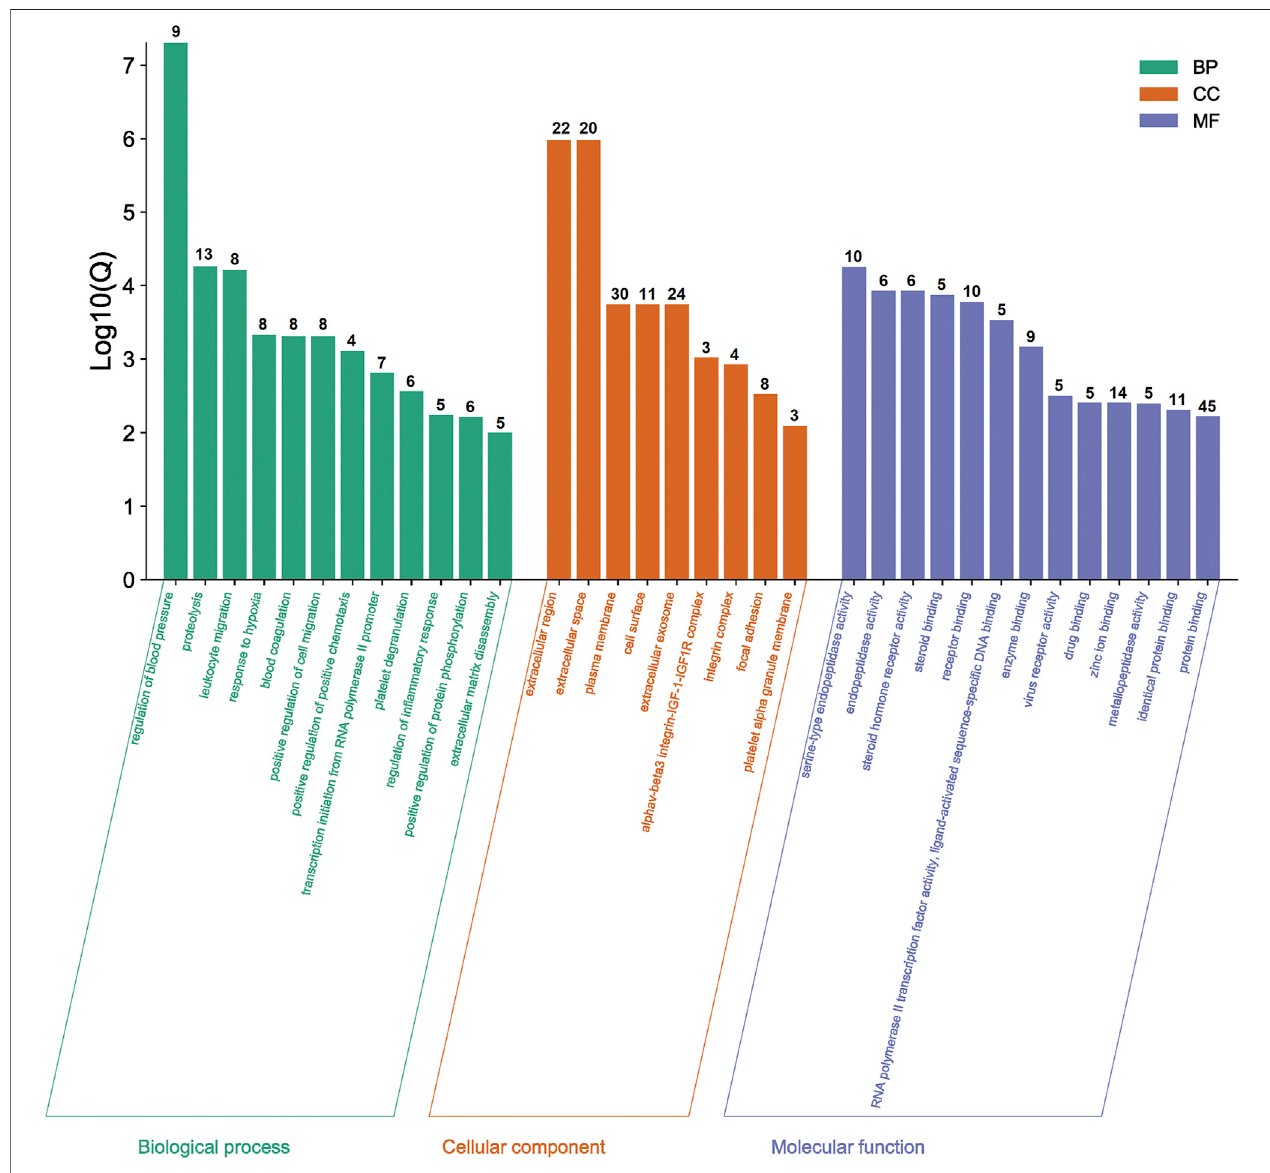
FIGURE 3 | Results of GO enrichment analysis. The number of genes in each category is shown on top of each bar.